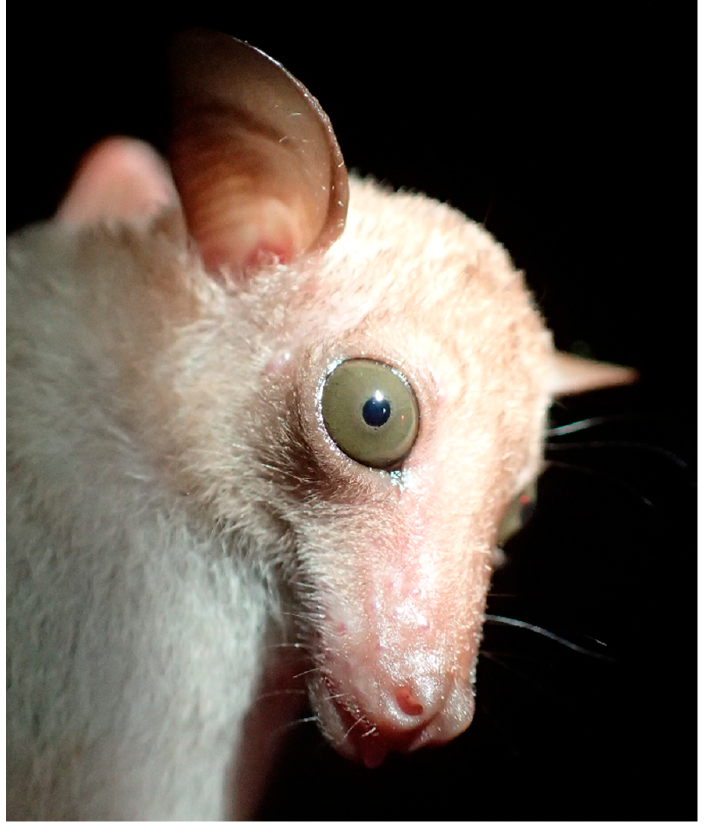
Figure 3. Macroglossus minimus , adult female. Photograph by Vu Dinh Thong.